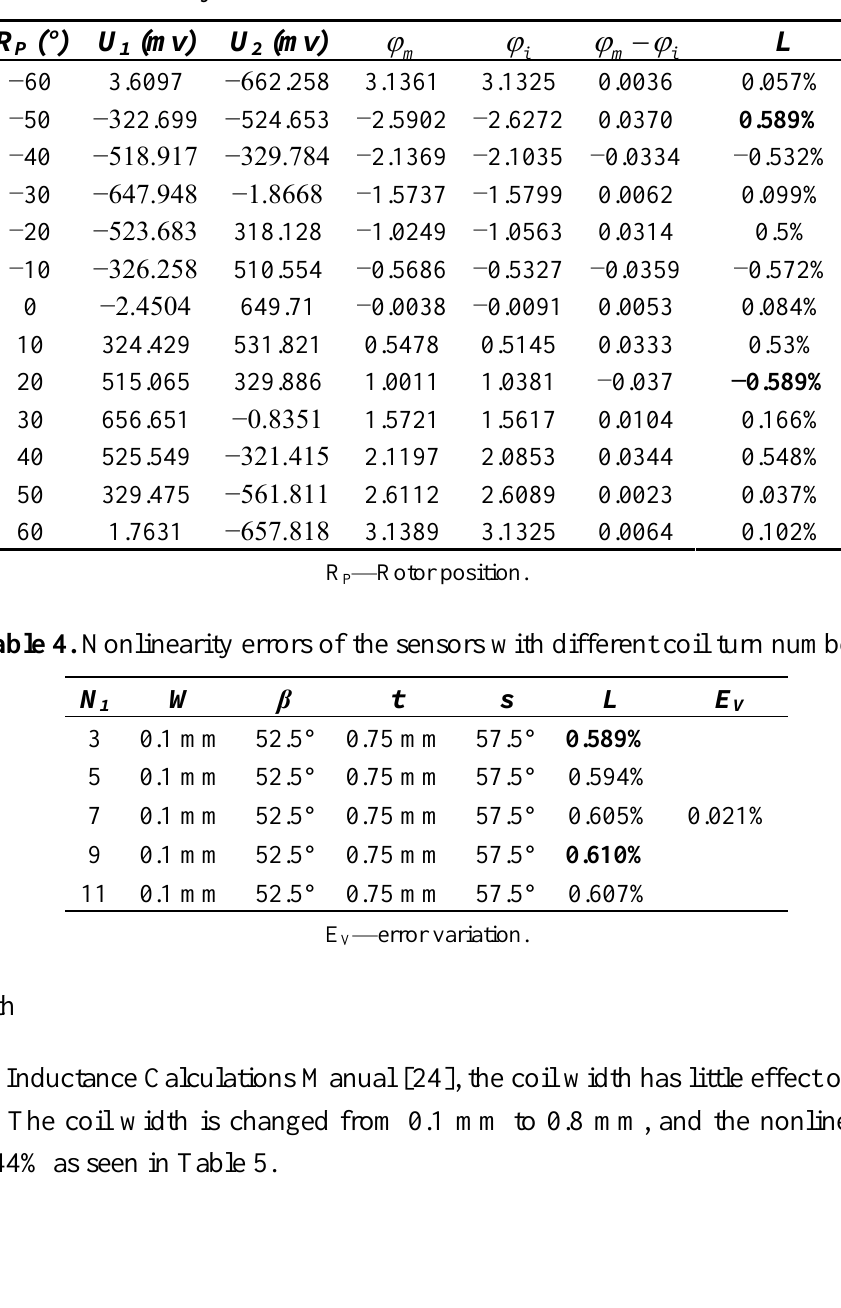
Table 3. Nonlinearity error of the sensor with three turns of the excitation coil.